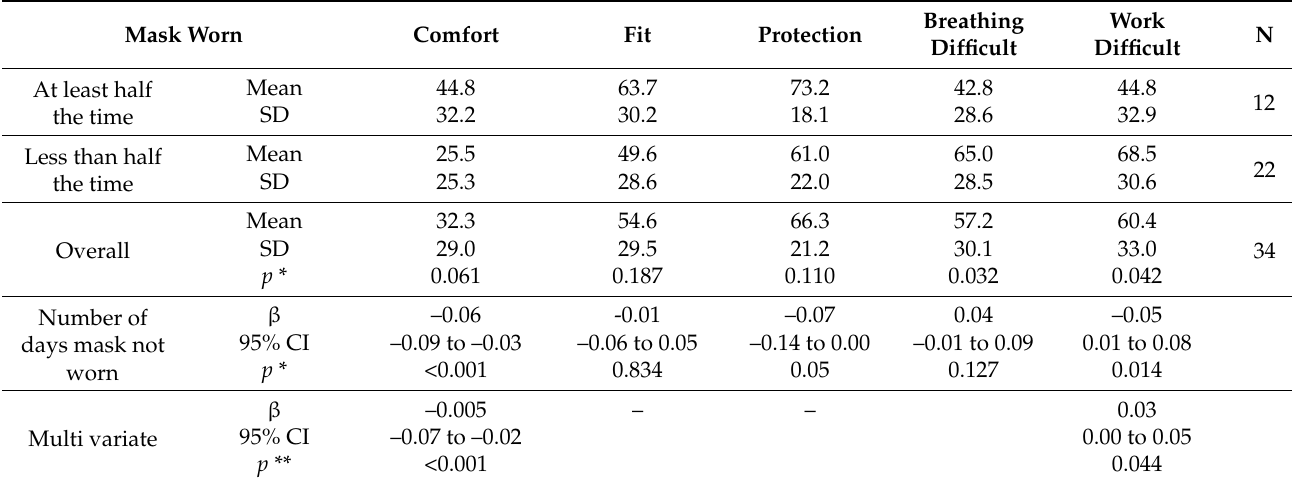
Table 7. Visual analogue rating of 5 aspects of mask wearing by frequency of use and number of days mask not worn.